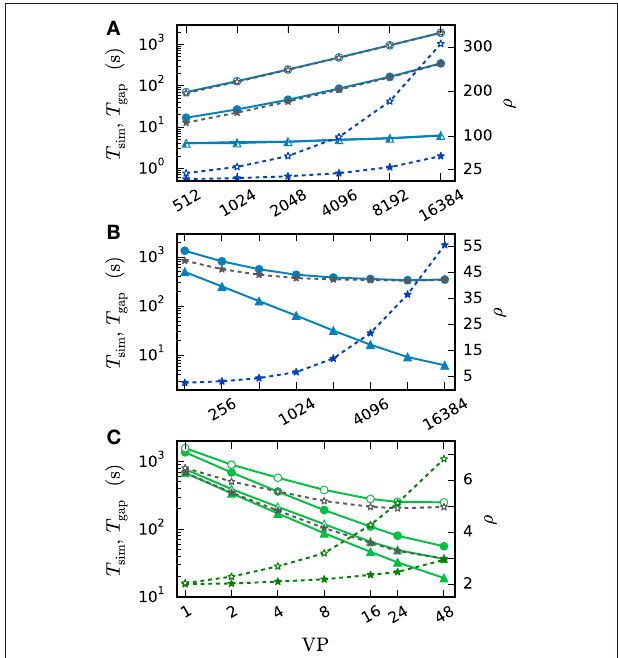
FIGURE 13 | Costs of the gap-junction dynamics. Open symbols show the results with h -step communication ( T = h ) while filled symbols show the results with the original NEST communication scheme ( T = d min , here d min = 1 ms ). The solid curves with triangles indicate the simulation time T sim in the absence of gap junctions. The corresponding darker blue curves with asterisks show the ratio ρ of T sim with and without gap junctions, while gray curves with asterisks show the difference T gap of both simulation times. Simulations represent 50 ms of biological time for (A,B) and 100ms for (C) at a step size of h = 0 . 05ms . All simulations use only a single iteration per time interval. (A) Weak scaling of Test case 1 b on JUQUEEN with N = 185 · VP neurons. (B) Strong scaling of Test case 1b on JUQUEEN